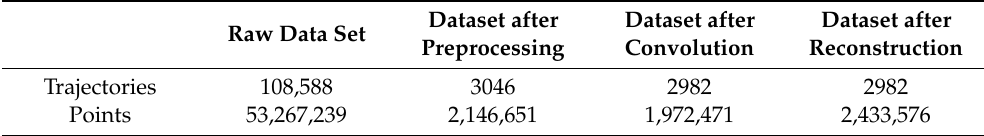
Figure 8. Comparison of denoising and reconstruction results in the Arctic Ocean. ( a ) The results after simple data preprocessing; ( b ) the results after the deep convolution operation; ( c ) the reconstructed trajectories results. Table 2. The data and trajectory information on the Arctic Ocean .